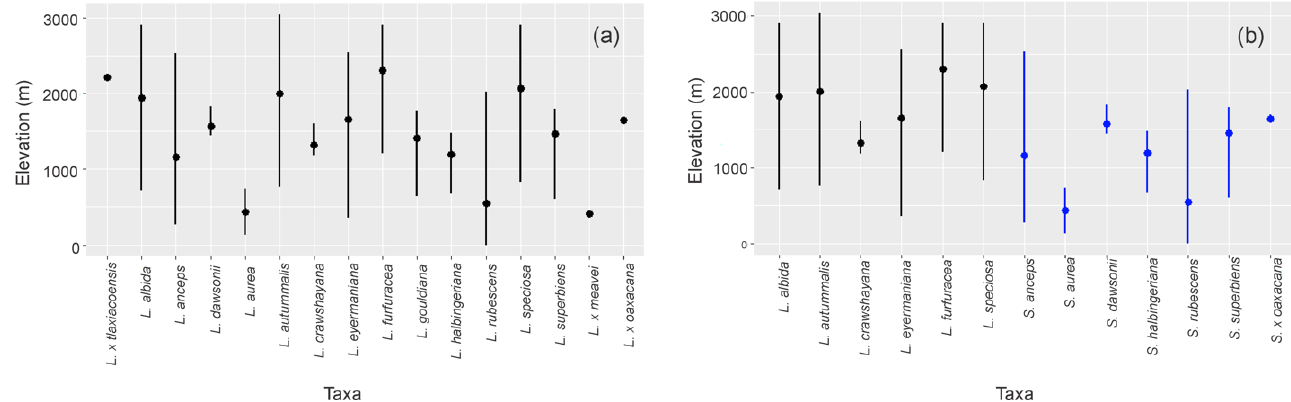
Figure 4. Elevation range by taxon for ( a ) Laelia s.l., ( b ) Laelia s.s., and Schomburgkia .